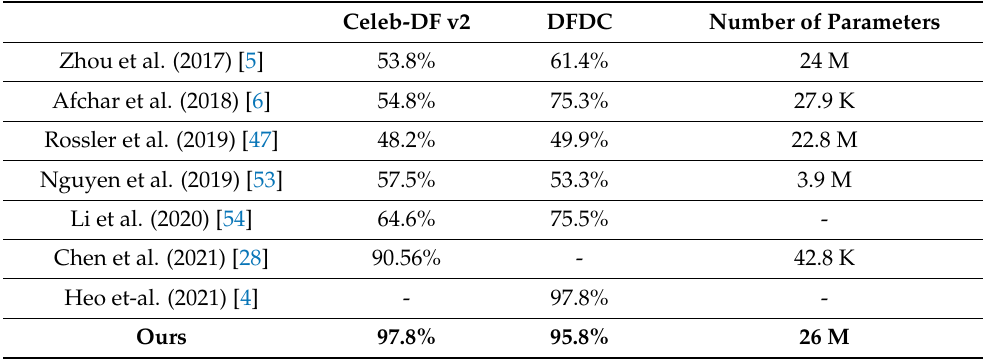
Table 3. Comparison of the detection performance of benchmarking methods with the AUC value. The AUC results of benchmarking methods are taken from [4,28,52].